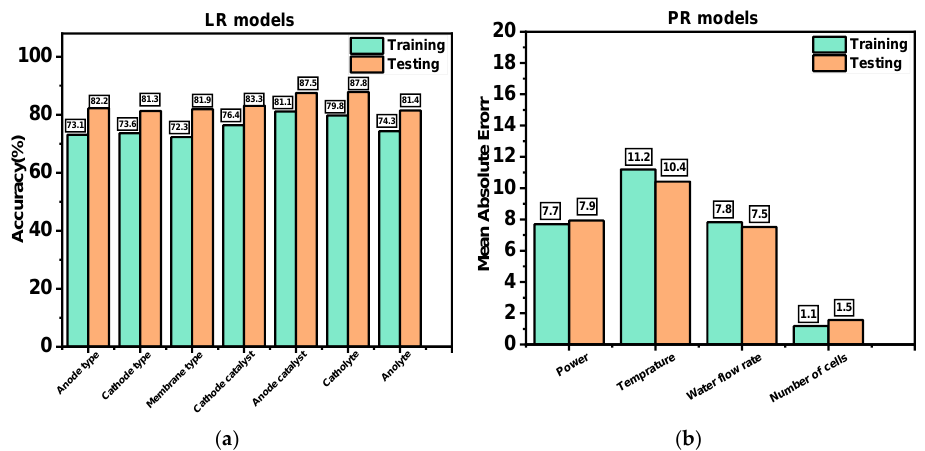
Figure 5. Training and Testing Accuracy/MAE for each ML model. ( a ) Training/Testing Accuracy for each classification model (anode type, cathode type, membrane type, cathode catalyst, anode catalyst, catholyte, and anolyte); ( b ) Training/Testing MAE for each regression model (power, temperature, water flow rate, and number of cells).